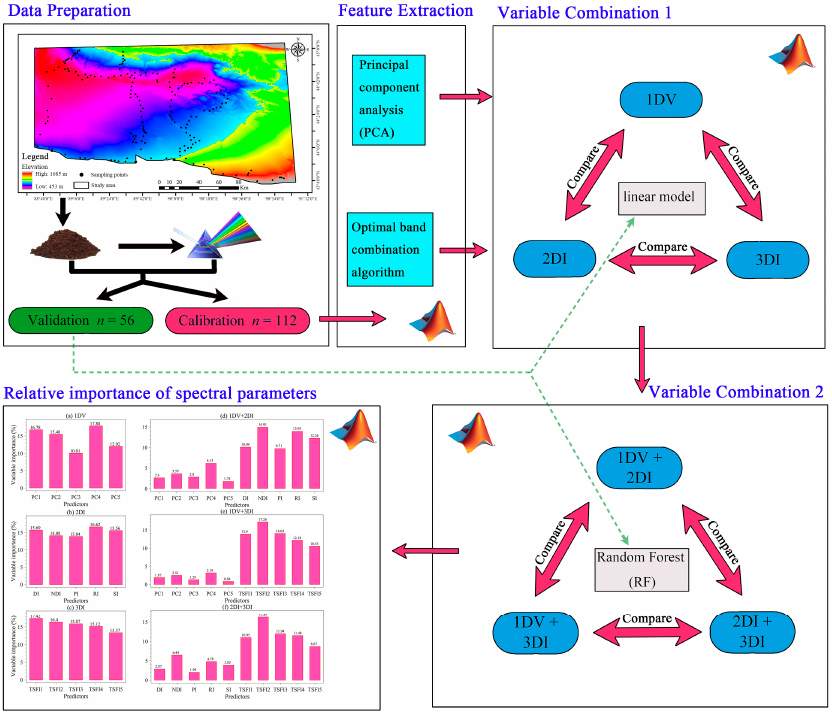
Figure 2. Flow chart of the current work.